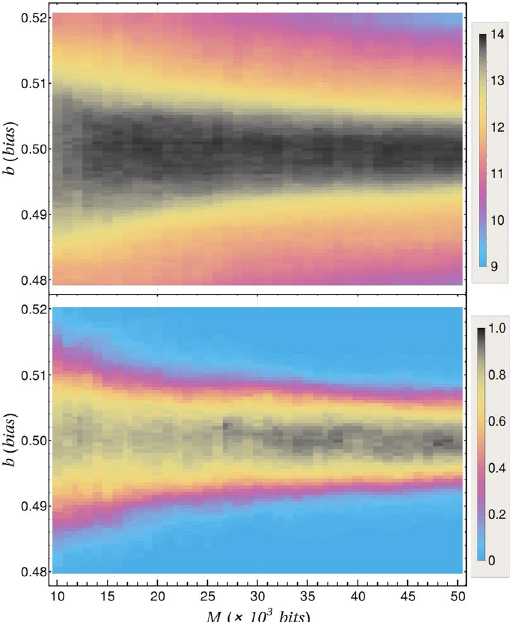
Figure 1. Phase diagram of Randomness Characterisation. Division of the parameter space into regions according to the likeliest model. The top figure corresponds to β = 1 in terms of the frequency γ 0 of the string 0 and the sample size M . The green curves corresponds to Borel’s normality criterion, while the red curves are Borel-type bounds obtained by an approximation obtained from Eq. (4) (see Sec. 3 of SI). The bottom plot corresponds to β = 2 where each coloured area identifies the likeliest model in that region. Here we fixed the frequencies γ 1 = 1/6 and γ 2 = 1/4 and varied the frequency γ 0 of the string 00 and the sample size M